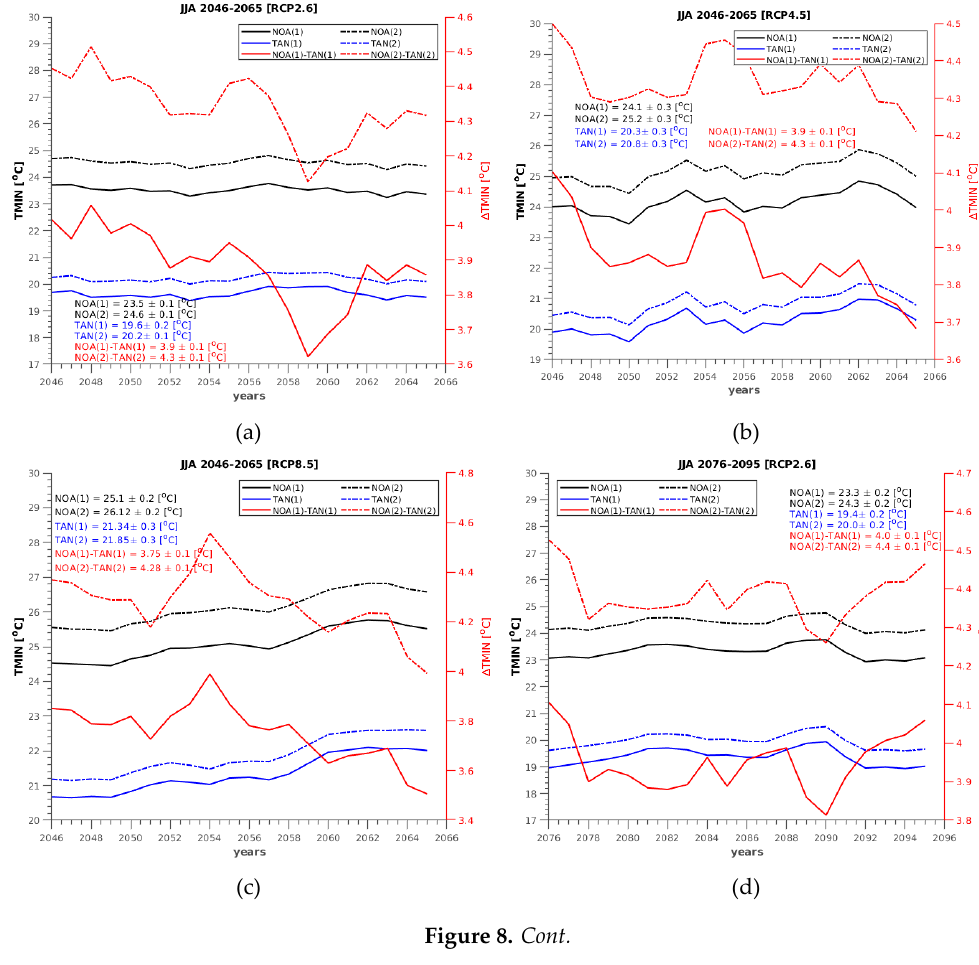
Figure 7. ( a – f ): Summer averaged maximum temperatures (T max ) and UHI max ( Δ T max ) for the near and distant future periods (2046–2065 and 2076–2095) under climate scenarios RCP2.6, RCP4.5, and RCP8.5. For each period and scenario, simulations NOA (1)/TAN (1) are calibrated against the first reference period (1976–1995) under UHI regime UHI_1 and simulations NOA (2)/TAN (2) are calibrated against the second reference period (1996–2015) under UHI regime UHI_2. Averaged mean change with respective confidence interval is given in the figures for each projection.